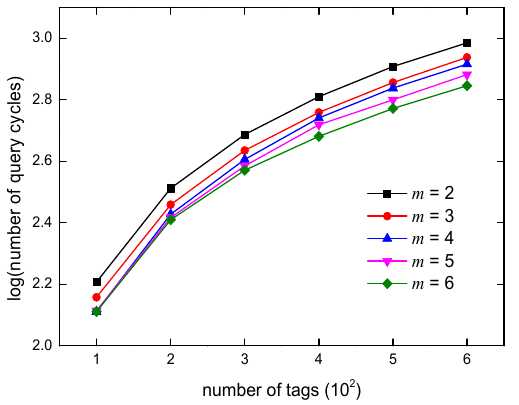
Figure 7. Comparison of query cycles.